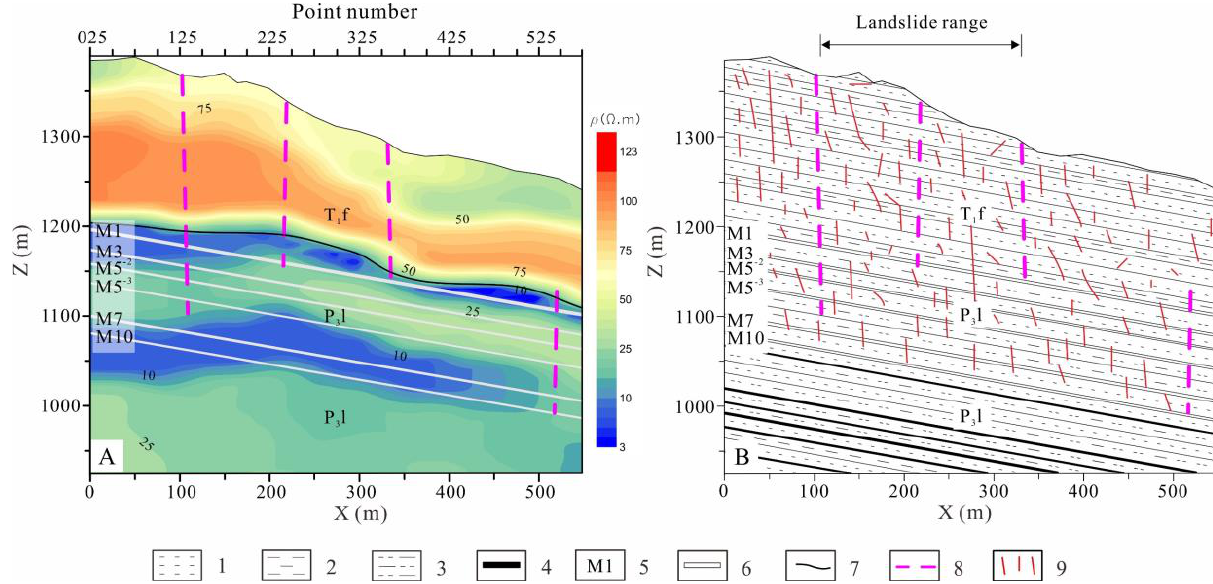
Figure 16. Surface transient electromagnetic inversion map of survey line IV − IV ′ : ( A ) section isoline of the apparent resistivity; and ( B ) geological section. (The legend meanings are shown in Figure 14).